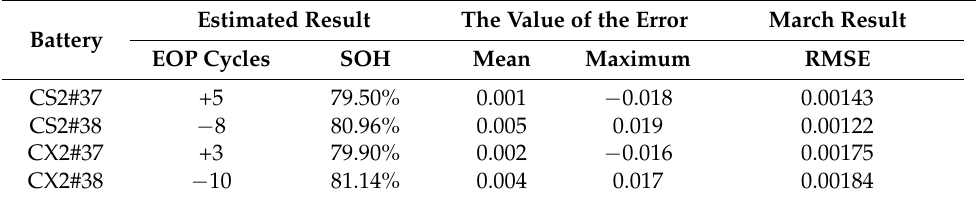
Table 3. Summary of experimental